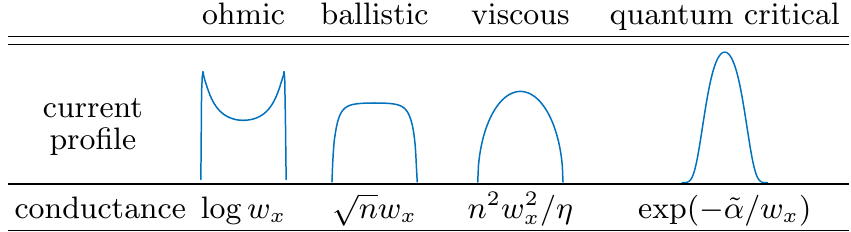
TABLE 1. Summary of how to distinguish between